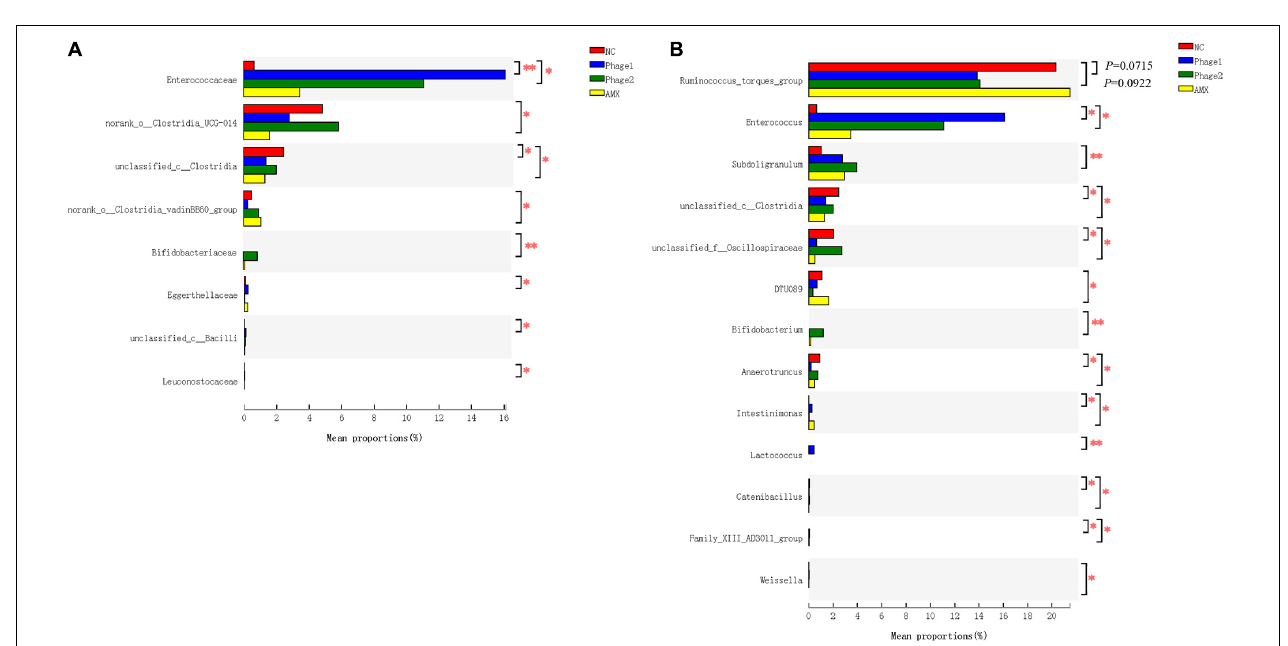
FIGURE 8 | Effect of phages on the relative bacterial abundance in chicks. Analysis of the differential flora of cecal microbiota at (A) family level and (B) genus level. The Kruskal–Wallis H test was used for multi-group comparison of cecal microorganisms, and Scheffe post hoc tests were used to test the difference between any two groups. NC, negative control; Phage 1, 10 9 PFU GRNsp6 (day 3-5); Phage 2, 10 9 PFU GRNsp6 (day 8-10); AMX, 1 mg/ml amoxicillin (day 8-10). ∗ p < 0.05; ∗∗ p < 0.01; and p < 0.1 trend.